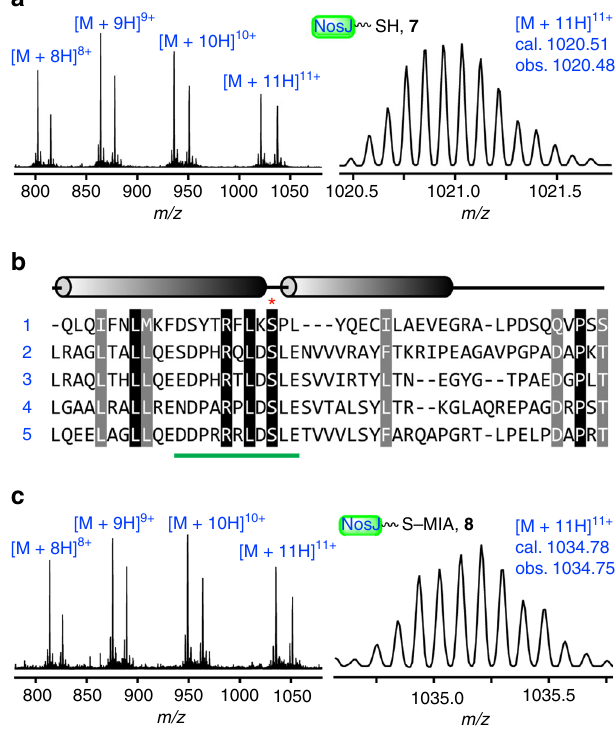
Fig. 3 NosJ is a previously unknown carrier protein. a HR-MS data of holo- NosJ ( 7 ) produced from E. coli BAP1, a strain that constitutively expresses sfp . b Sequence alignment of NosJ-homologous proteins, including ( 1 ) human RGS12 (which is a regulator of G-protein signaling, PDB: 2EBZ_A), ( 2 ) EPJ36919.1, ( 3 ) SCF35178.1, ( 4 ) NocK ADR01086.1 and ( 5 ) NosJ ACR48339.1. The conserved Ser residues (Ser36 in NosJ) onto which the Ppant arm is attached were shown with a red asterisk. The NosJ 28 – 38 Glu_C fragment was shown by a green bar. A NosJ homology model was shown in Supplementary Fig. 4. c HR-MS data of NosJ-bound MIA ( 8 ) produced by